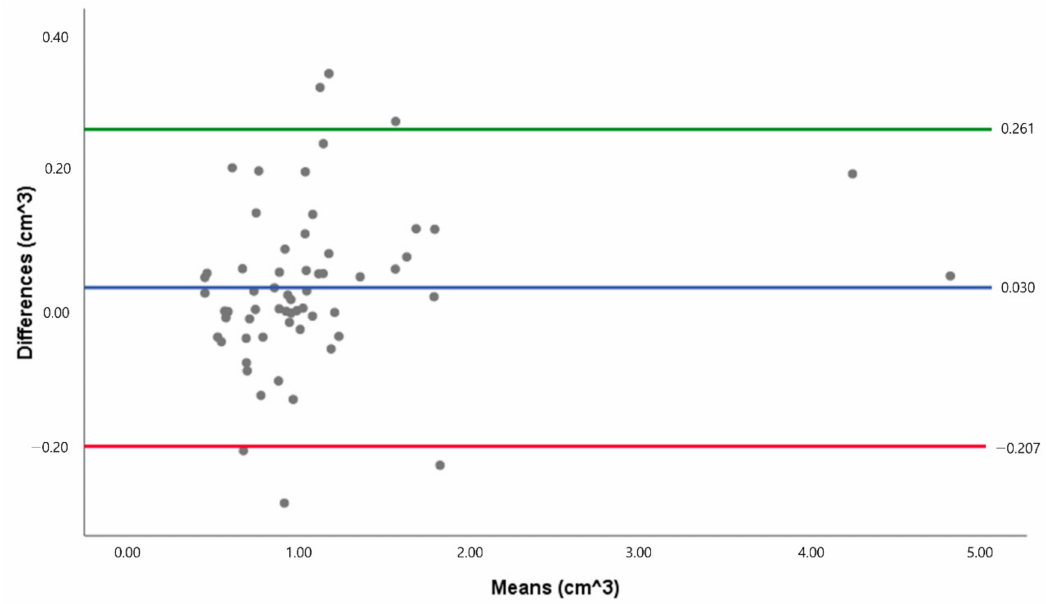
Figure 6. Bland-Altman plot of the total volume data set. The green line indicates the upper limit of agreement, while the red line indicates the lower limit of agreement (N =